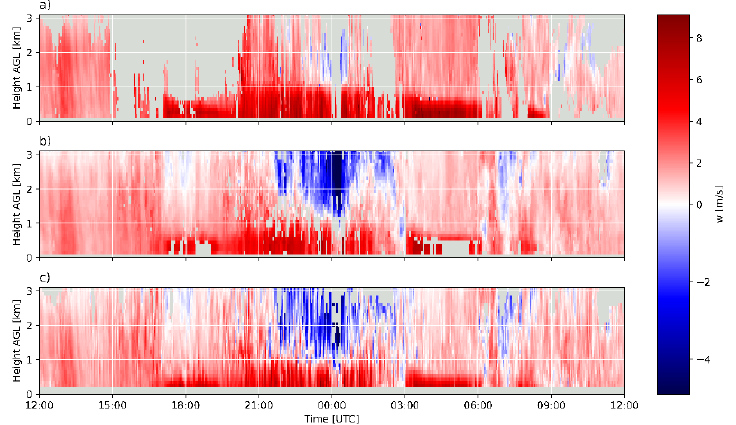
Figure 6. Vertical speed (downward defined positive) estimates for 24th to 25th March 2017. ( a ) MRR2, ( b ) RWP (Method1) and ( c ) RWP